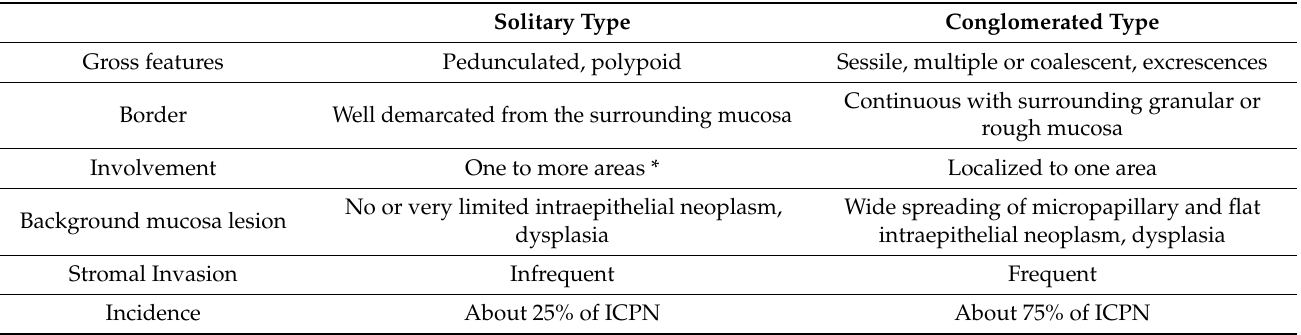
Table 6. Main differences of solitary vs. conglomerated ICPN (intracholelcystic papillary